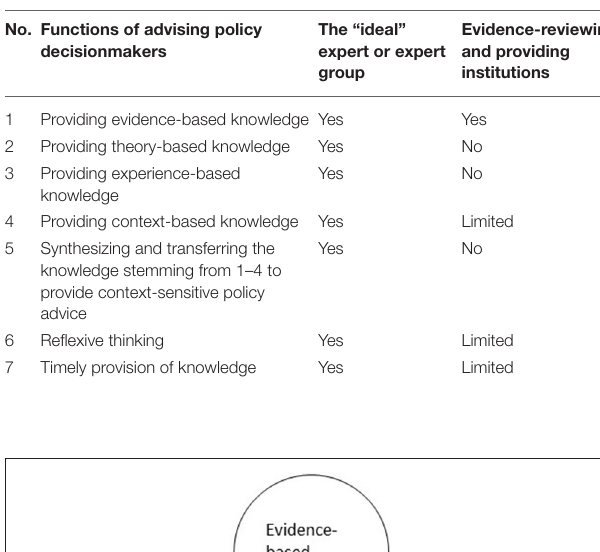
TABLE 3 | Knowledge-based health policy: Functions of advising policy decisionmakers.